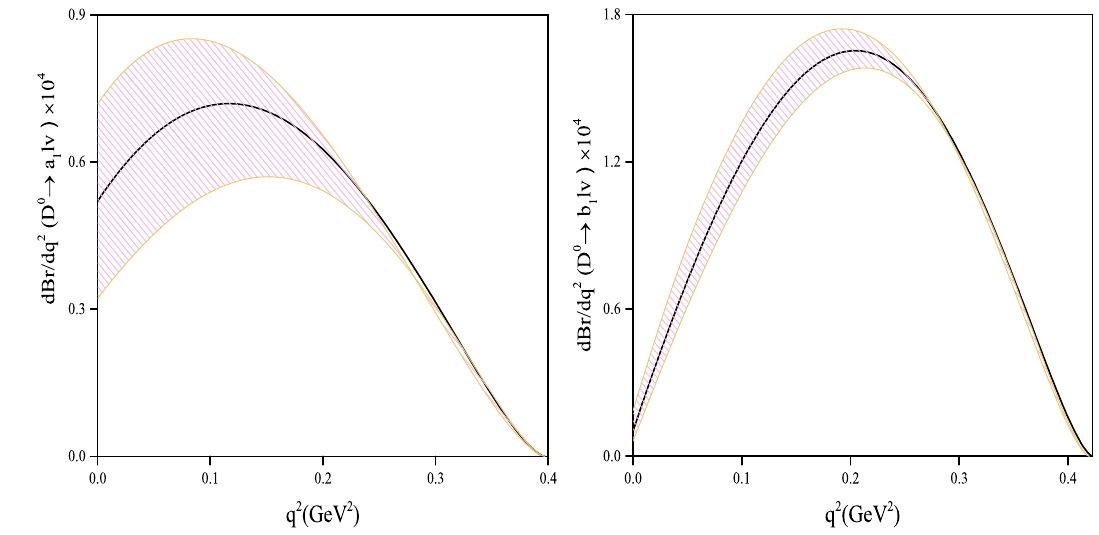
Fig. 5 The differential branching ratio of D 0 → a − using the upper and lower values of the input parameters